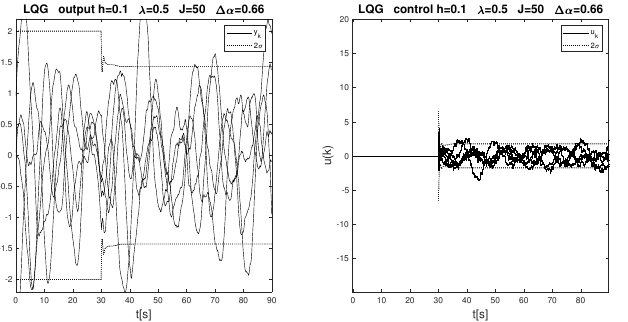
Figure 7. Realization of the output ( left ) and control ( right ) signal for λ = 0.5 and ∆ α = 0.66.